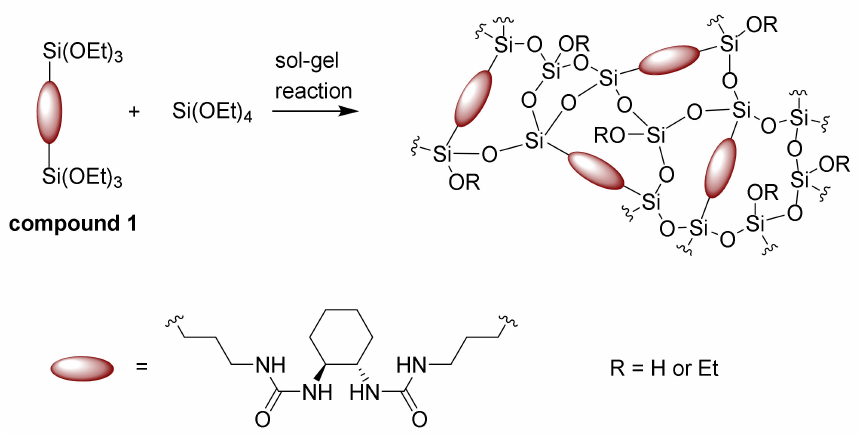
Figure 1. The sol-gel process of forming pure hybrid organosilane fibres based on compound 1